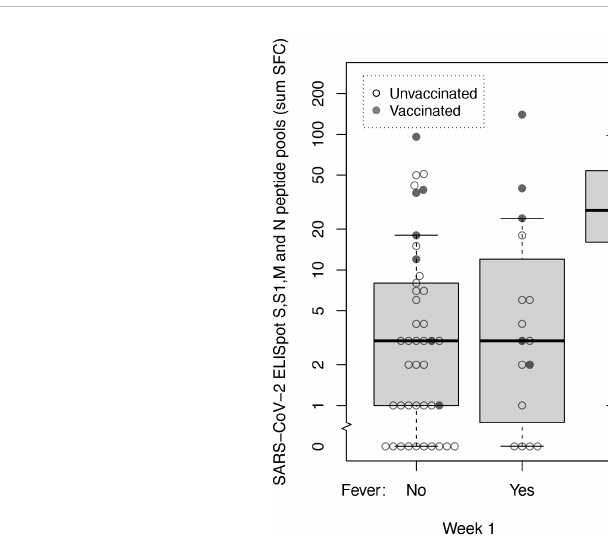
FIGURE 2 SARS-CoV-2 speci fi c T-cell responses at week 1 and 4 after symptom onset measured by ELISpot with spike, membrane and nucleocapsid peptide pools in non-hospitalized subjects with mild COVID-19. T-cell reactivity against spike (S and S1), membrane (M) and nucleocapsid (N) peptide pools (sum SFC) measured by ELISpot in week 1 and 4 after symptom onset in healthcare workers with mild COVID-19 without fever (n=42) and with fever (n=16). Open dots represent unvaccinated subjects, closed dots represent subjects who were either fully or partially vaccinated with any SARS-CoV-